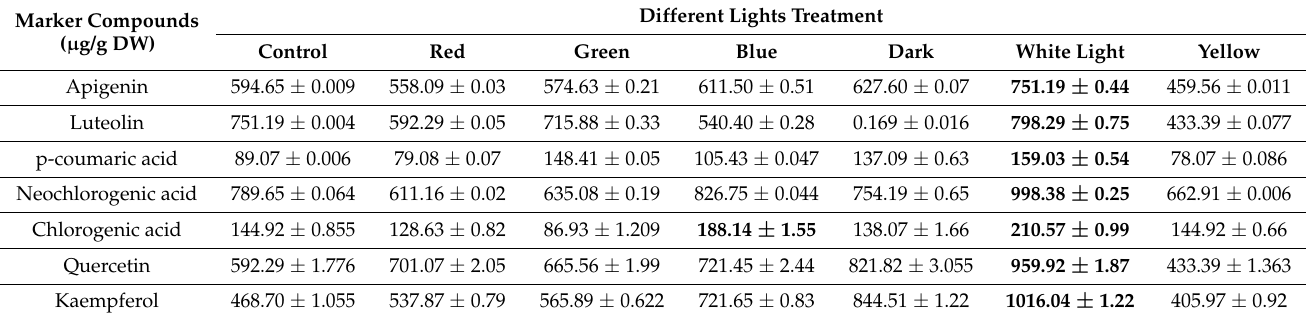
Table 1. The effect of multispectral light on the production of polyphenolic metabolites in an M. oleifera callus culture. Means and standard errors from triplicates are represented. The bold values indicate highest metabolite